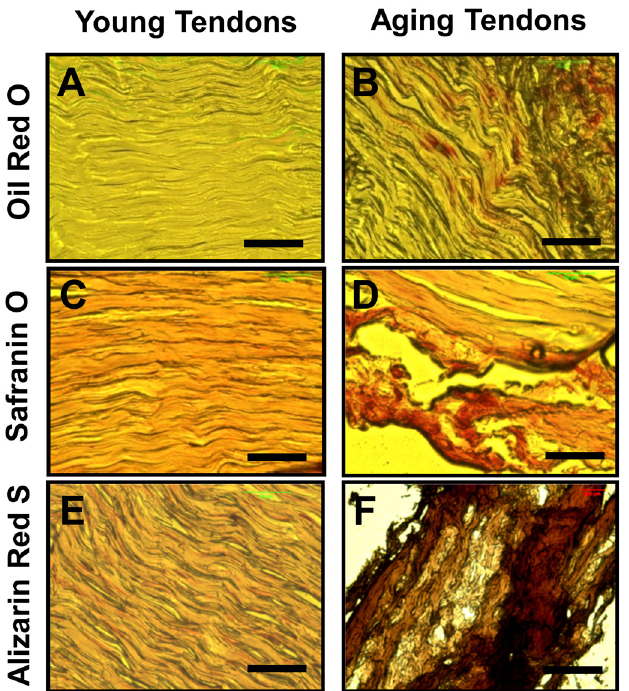
Fig 3. Histochemical analysis of patellar tendon sections from young (2.5 months) and aging (9 months) mice. Tendon sections were stained with Oil Red O ( A, B ), Safranin O ( C, D ) and Alizarin Red S ( E, F ) to detect the presence of lipids, proteoglycans, and calcium deposits, respectively. As shown, only minimal amounts of these non-tendinous tissues were detected in young tendons; in contrast, extensive amounts of these tissues were found in aging tendons. Bar — 50 μ